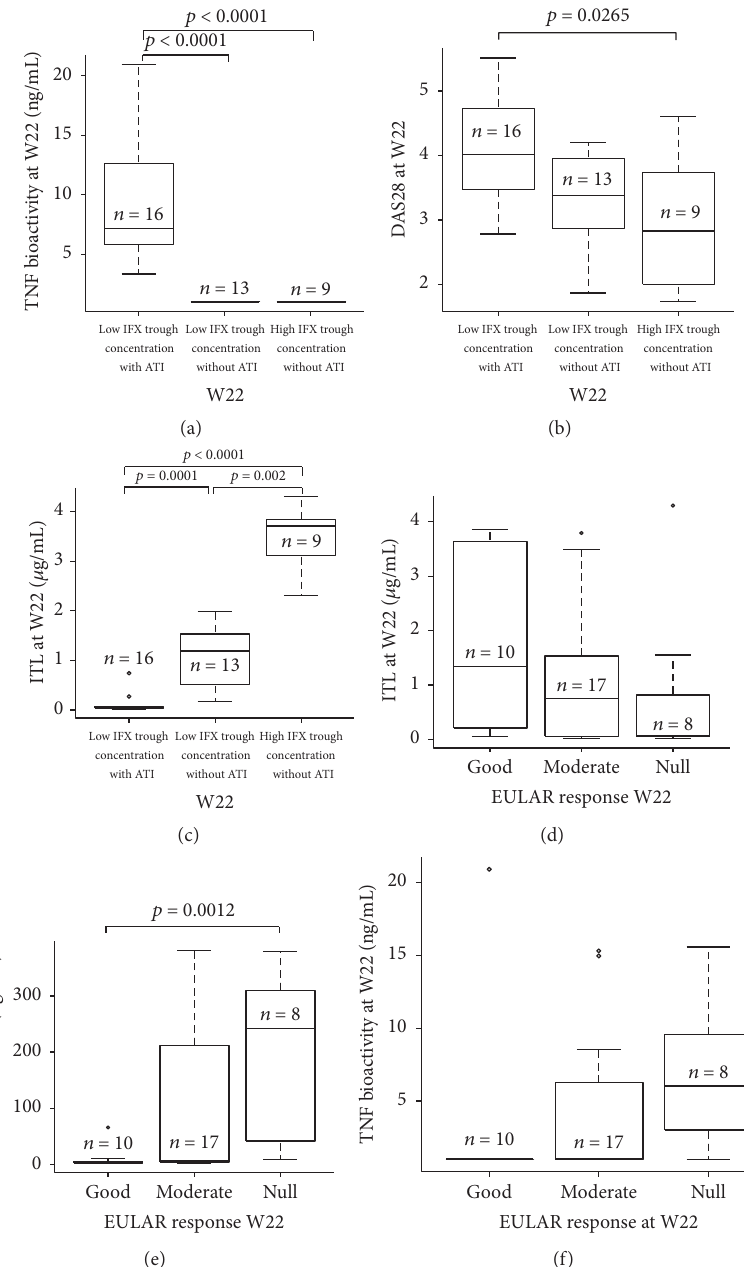
Figure 2: TNF bioactivity, DAS28, and IFX trough concentration at W22 in function of presence of IFX with or without ATI at W22 and IFX trough concentration and ATI at W22 and clinical response at W22. High TNF bioactivity was observed in the group “Low IFX trough concentration with ATI,” but not in the groups “Low IFX trough concentration without ATI” and “High IFX trough concentration without ATI” ((a) Kruskal-Wallis rank sum test; 𝑝 < 0.0001 ). DAS28 was higher in the “Low IFX trough concentration with ATI” group compared to the two others ((b) Kruskal-Wallis rank sum test; 𝑝 = 0.0266 ). IFX trough concentration at W22 was heterogeneous in the three groups ((c) Kruskal-Wallis rank sum test; 𝑝 < 0.0001 ) with highest IFX trough concentration in the group “High IFX trough concentration without ATI.” Furthermore, IFX trough concentration was higher in the group “Low IFX trough concentration without ATI” than in the group “Low IFX trough concentration with ATI” ((c) 𝑝 < 0.0001 ). IFX trough concentration was higher in the group “High IFX trough concentration without ATI” than in the group “Low IFX trough concentration without ATI” ((c) 𝑝 = 0.0002 ). A trend for high IFX trough concentration and good EULAR response was observed at W22 ((d) Kruskal-Wallis rank sum test 𝑝 = 0.1526 ). Oppositely, ATI concentration was not detectable in good response and high in Null response at W22 ((e) Kruskal-Wallis rank sum test 𝑝 = 0.0047 ). At W22, a trend between TNF bioactivity and EULAR response (f). TNF bioactivity was not detectable in good response and high in Null response at W22 (Kruskal-Wallis rank sum test; NS). The box plots show the median values and the first and third quartiles at each time. The T bars represent the rest of the data with a maximum of 1.5 times the interquartile range. Circles represent values lower or higher than 1.5 times the interquartile range. TNF: